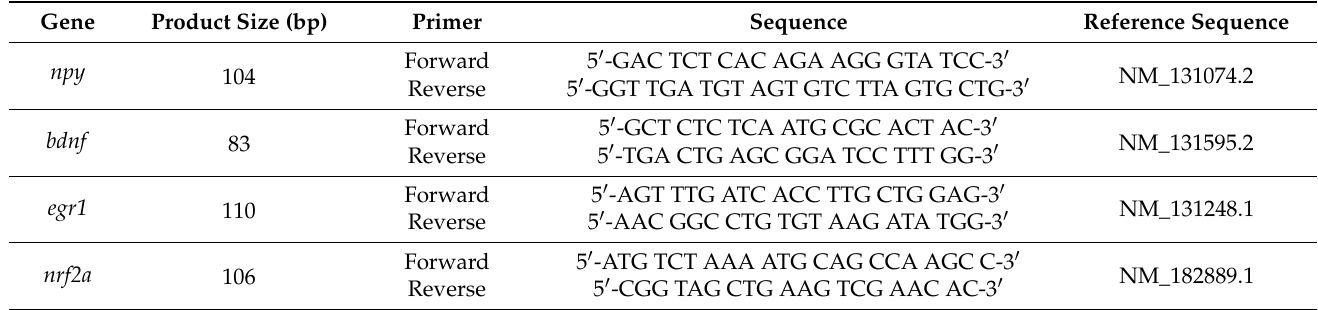
Table 1. Primers used to amplify the genes of interest in Danio